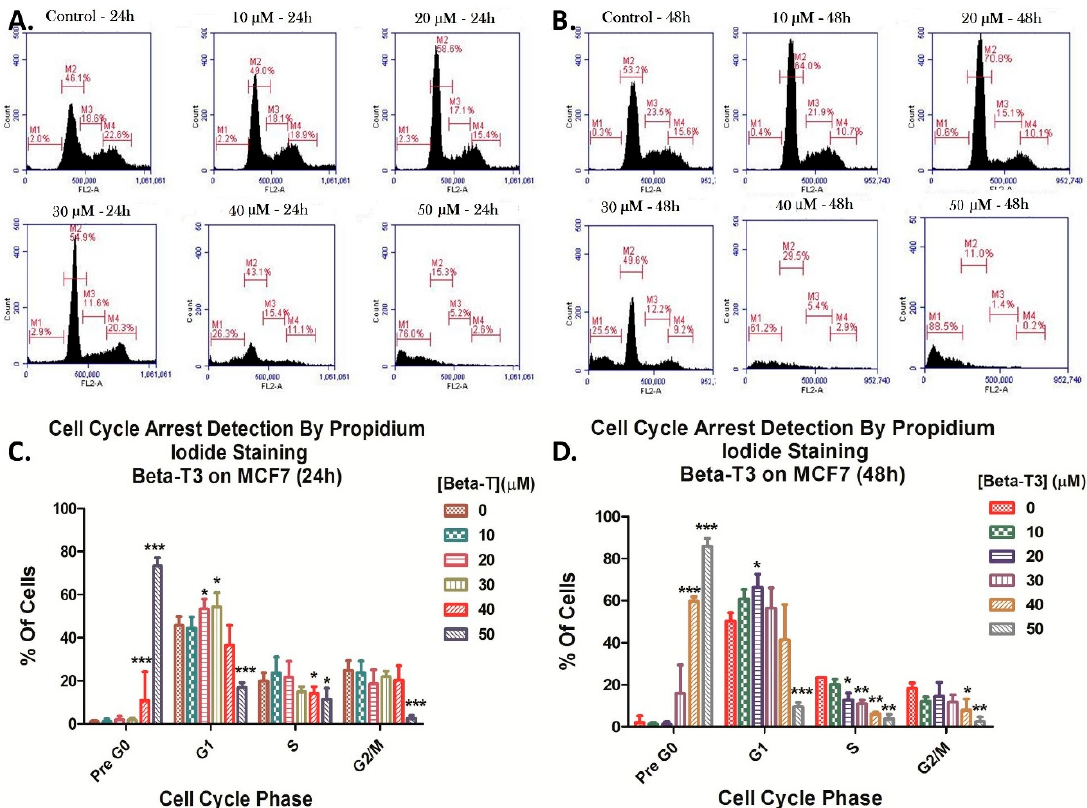
Figure 4. Beta-tocotrienol induced a cell cycle arrest of ER-( + ve) MCF7 cells. Cell cycle distribution was assessed by flow cytometry after propidium iodide staining using the range of concentrations: 0–50 µ M for 24 ( A ) or 48 h ( B ). Figures ( A ) and ( B ) were obtained by the C Flow software. ( C ) and ( D ) represent histograms for analysis of the percentages of cells in each cell cycle phase upon treatment with beta-T3 for 24 and 48 h respectively. *, ** and *** indicate p < 0.05, p < 0.001 and p < 0.0001 respectively.